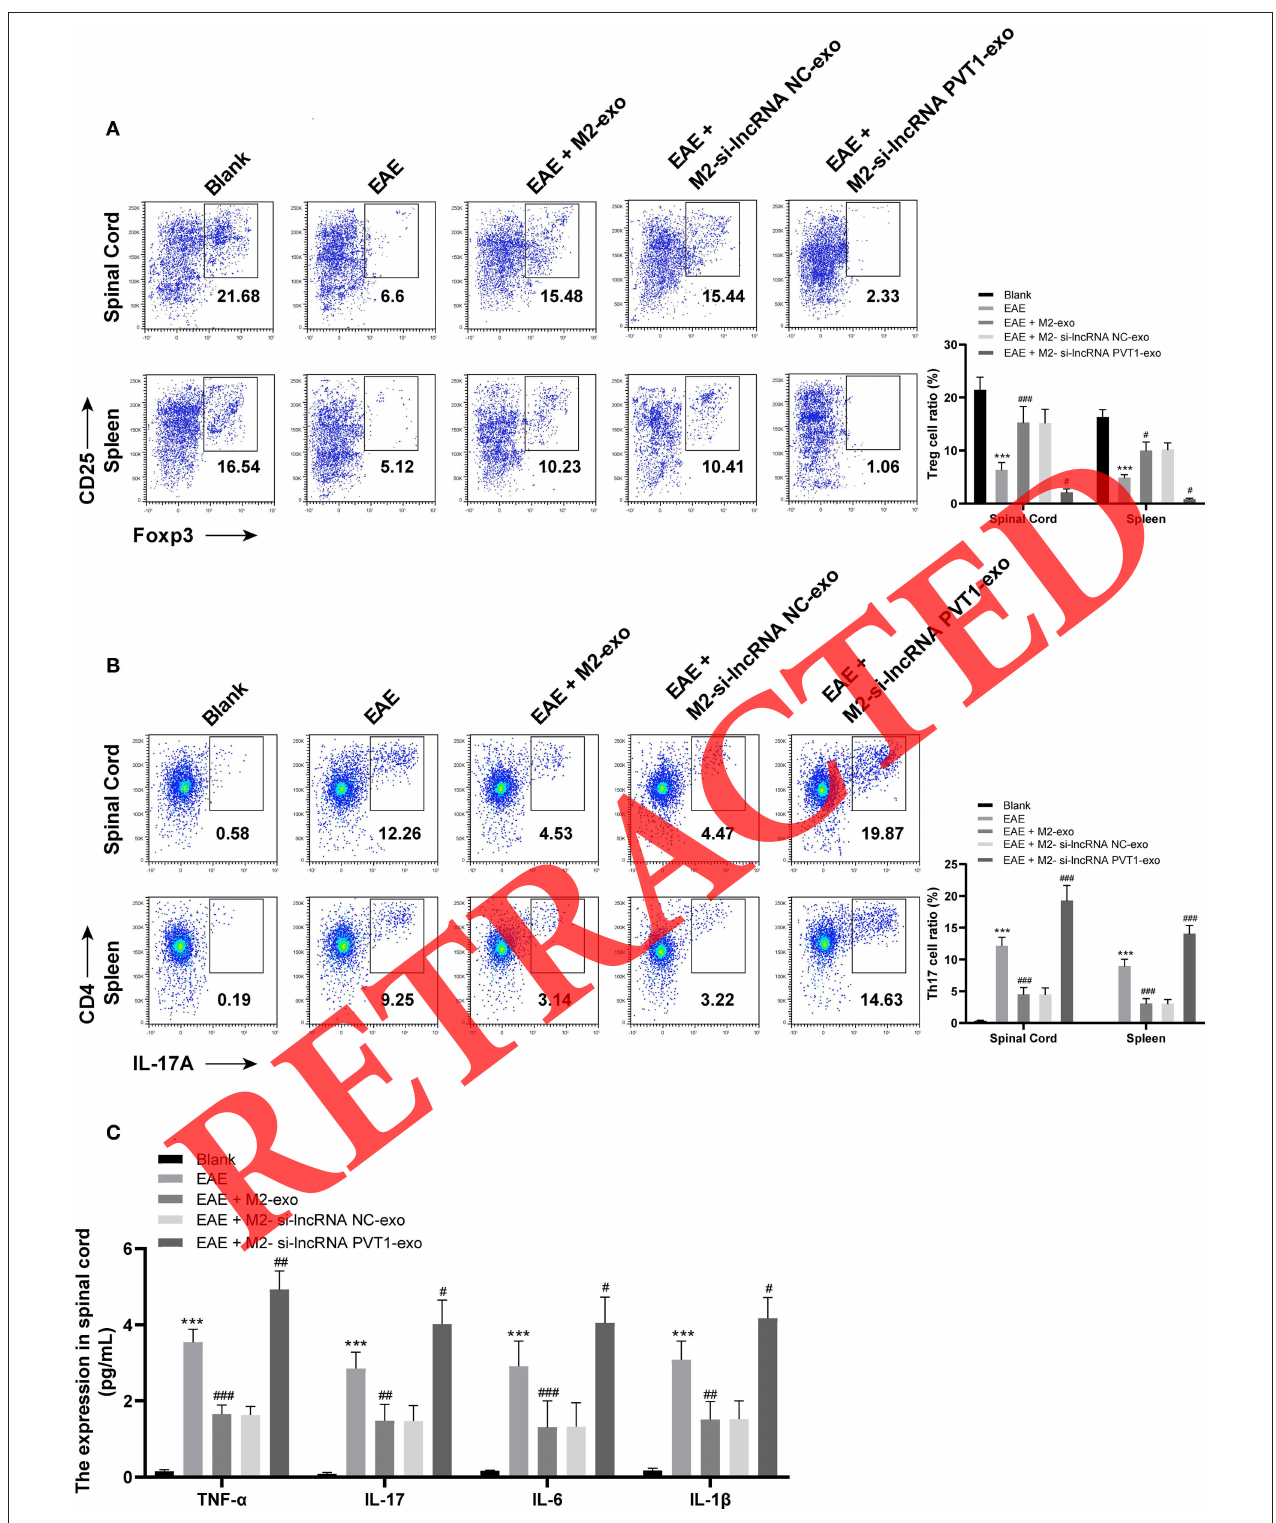
FIGURE 4 | LncRNA PVT1 inhibits the proinflammatory response induced by Th17 cells in EAE mice. (A,B) Detection of Treg and Th17 cells in spinal cord cells and splenocytes by flow cytometry; (C) Detection of inflammatory factors in spinal cord cells by ELISA. Compared with the blank group, *** p < 0.001; compared with the EAE group, # p < 0.05, ## p < 0.01, ### p < 0.001. Data are analyzed with two-way ANOVA, and Tukey’s multiple comparisons test was utilized for post hoc test n =